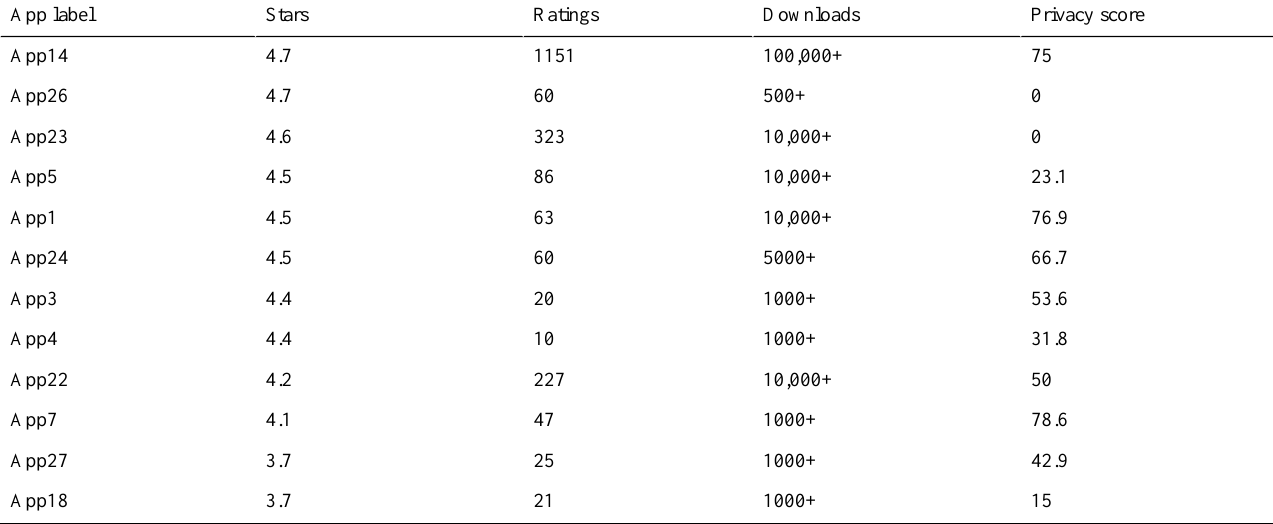
Table 6. Assessment of privacy policies by app